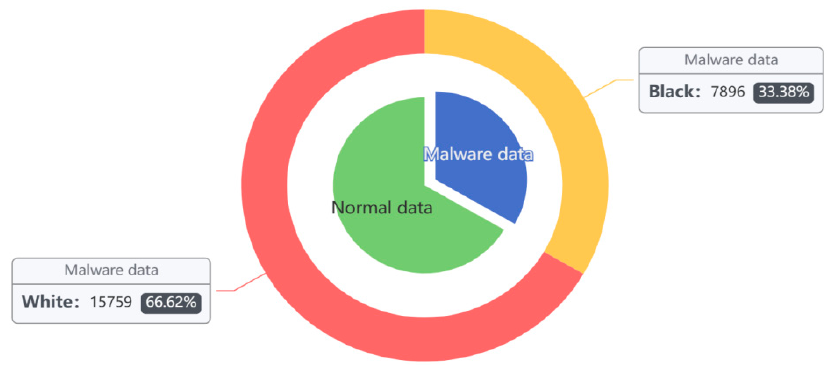
Table 2. Quantity Distribution of Sample DataCon Dataset.